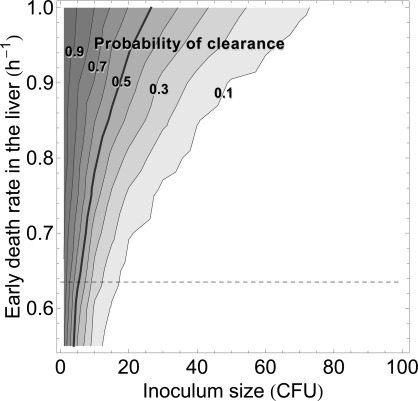
Estimated Probability of Clearance of Infection for Various Inoculum Sizes and Initial Death RatesProbability values shown along the isoclines were estimated as the proportion of stochastic simulations resulting in bacterial clearance. For each combination of inoculum size (horizontal axis) and death rate (vertical axis), we ran 1,000 simulations. Early death rate in the spleen was varied in line with that in the liver (i.e., the difference between the two parameters remained constant). The horizontal dashed line represents the baseline death rates as estimated from the experiments. The thick isocline represents the predicted ID50 (i.e., intravenous inoculum size giving a 50% risk of successful infection) read on the horizontal axis as a function of death rate read on the vertical axis. Variation in death rates might be achieved with different mouse strains or following treatment or immunisation. Other parameter values were as estimated from the experimental values.